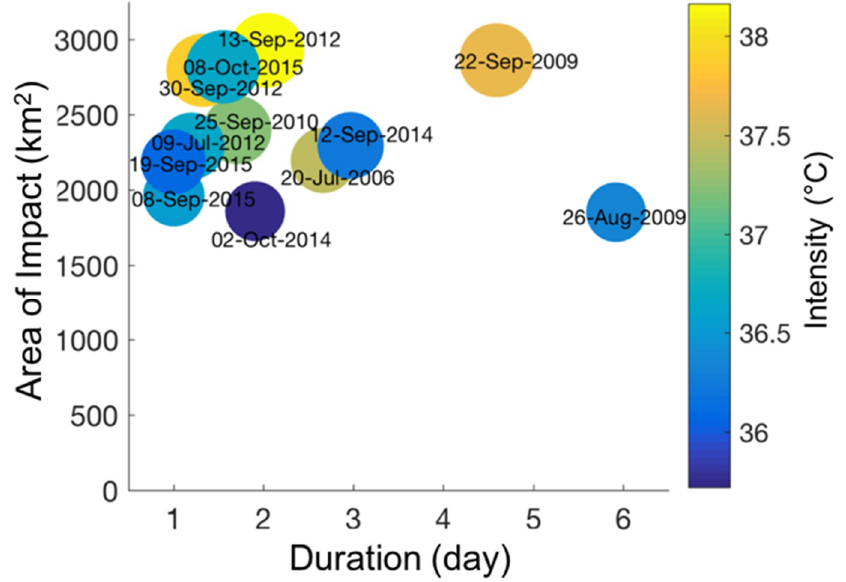
Figure 2. High-impact heat waves occurring in Los Angeles County during the historical period of 2001–2015: correspondence between heat waves’ area of impact, duration, and intensity (average daily maximum air temperature during the heat wave).